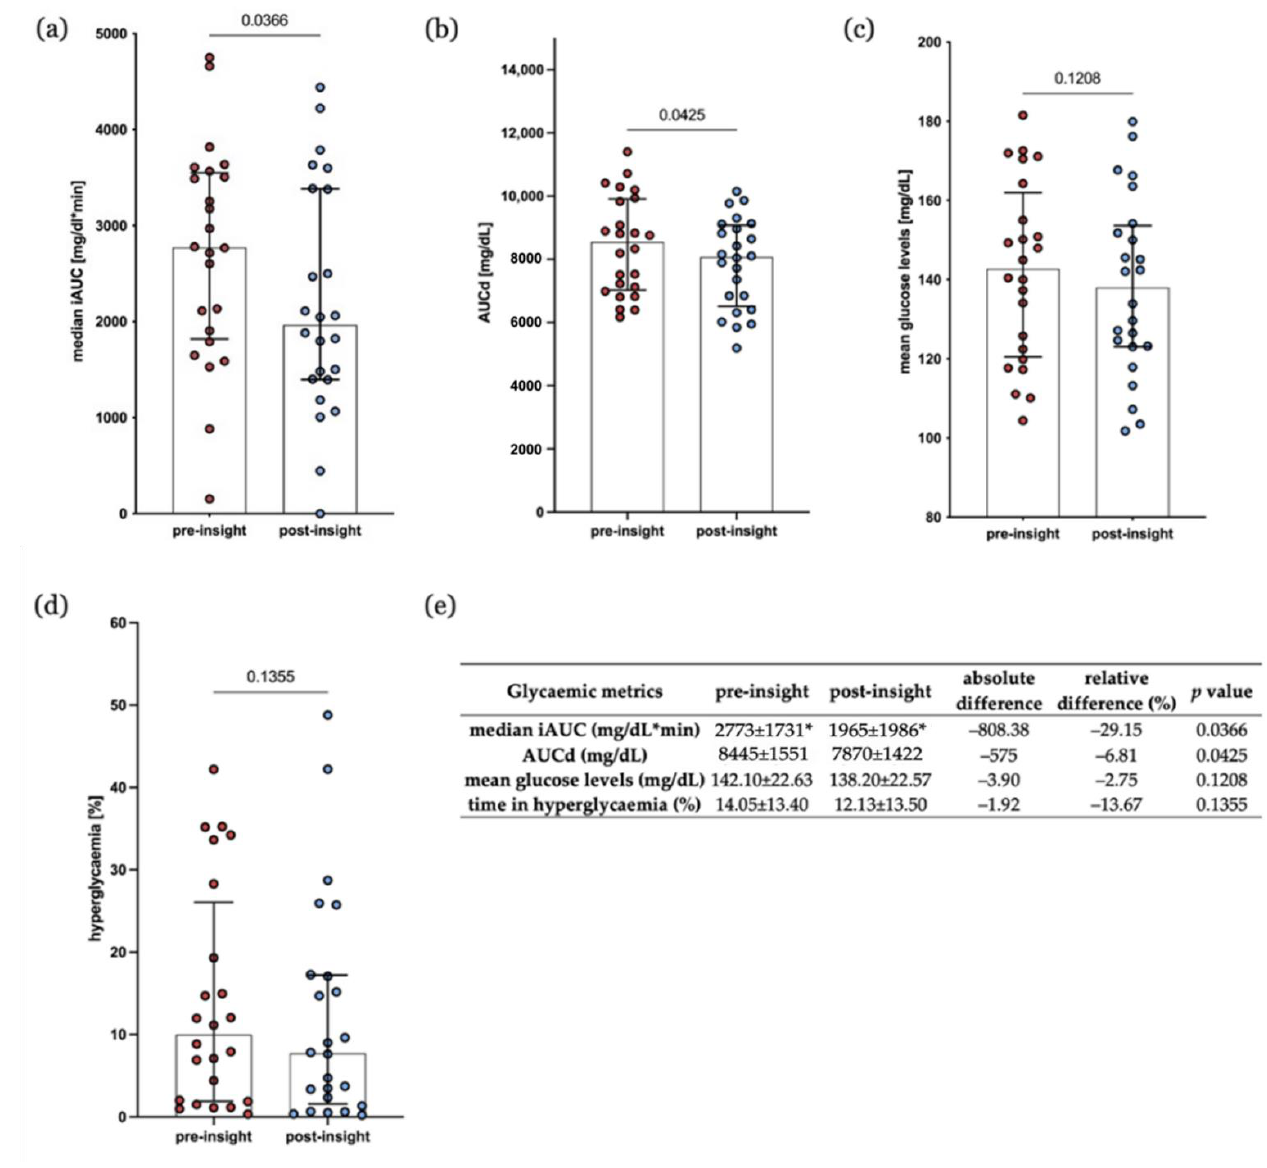
Figure 2. Glycaemic metrics pre- and post-insight phase. ( a ) The median incremental area under the curve (iAUC). ( b ) Daytime area under the curve (AUCd). ( c ) Mean glucose levels. ( d ) Percentage (%) of time spent in hyperglycaemia. ( e ) Summary statistics for ( a – d ) including relative difference (%), absolute difference, and p value. * For all metrics, mean ± SD is shown, except for median iAUC, for which median ± IQR is shown. ( a – d ) Each dot represents one individual participant. Wilcoxon matched-pair signed ranked test was chosen to test for significance; error bars show median ± IQR; n = 24.